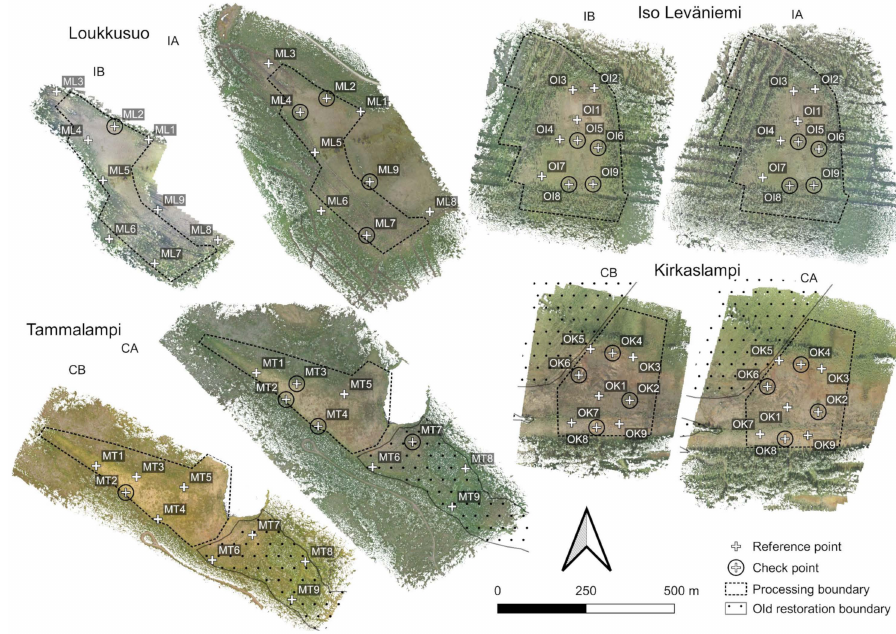
Figure 3. Composed orthomosaic pictures and processing boundaries. The Intervention Before (IB) and After (IA) campaigns were performed at the restoration sites and their simultaneous control campaigns (CB and CA, respectively) at the pristine sites. White crosses represent the distribution of the permanent ground control points, and the circles show the marker selection for reference (georeferencing) and control (testing the accuracy), depending on the georeferencing type (GCPs only/Real-Time Kinematic (RTK) onboard). The processing boundaries were drawn at a distance from the old restoration